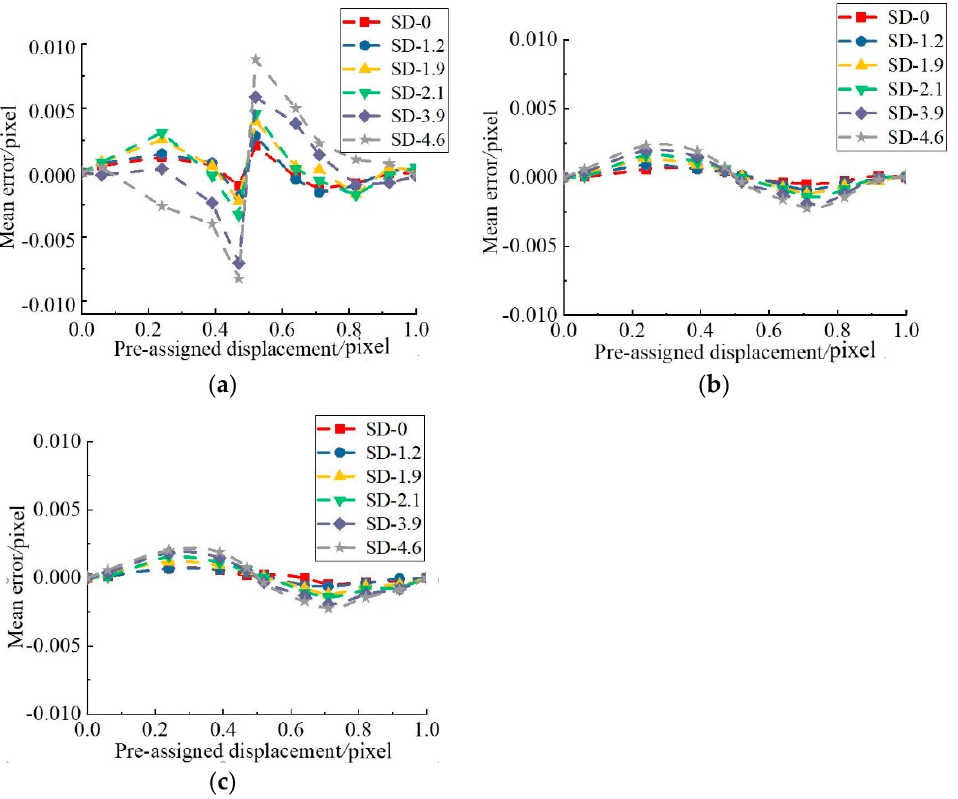
Figure 9. Mean errors of displacements measured with different noise level by ( a ) GB, ( b ) DPG, and ( c ) N–R method. Table 2. Computation ef fi ciency comparison.